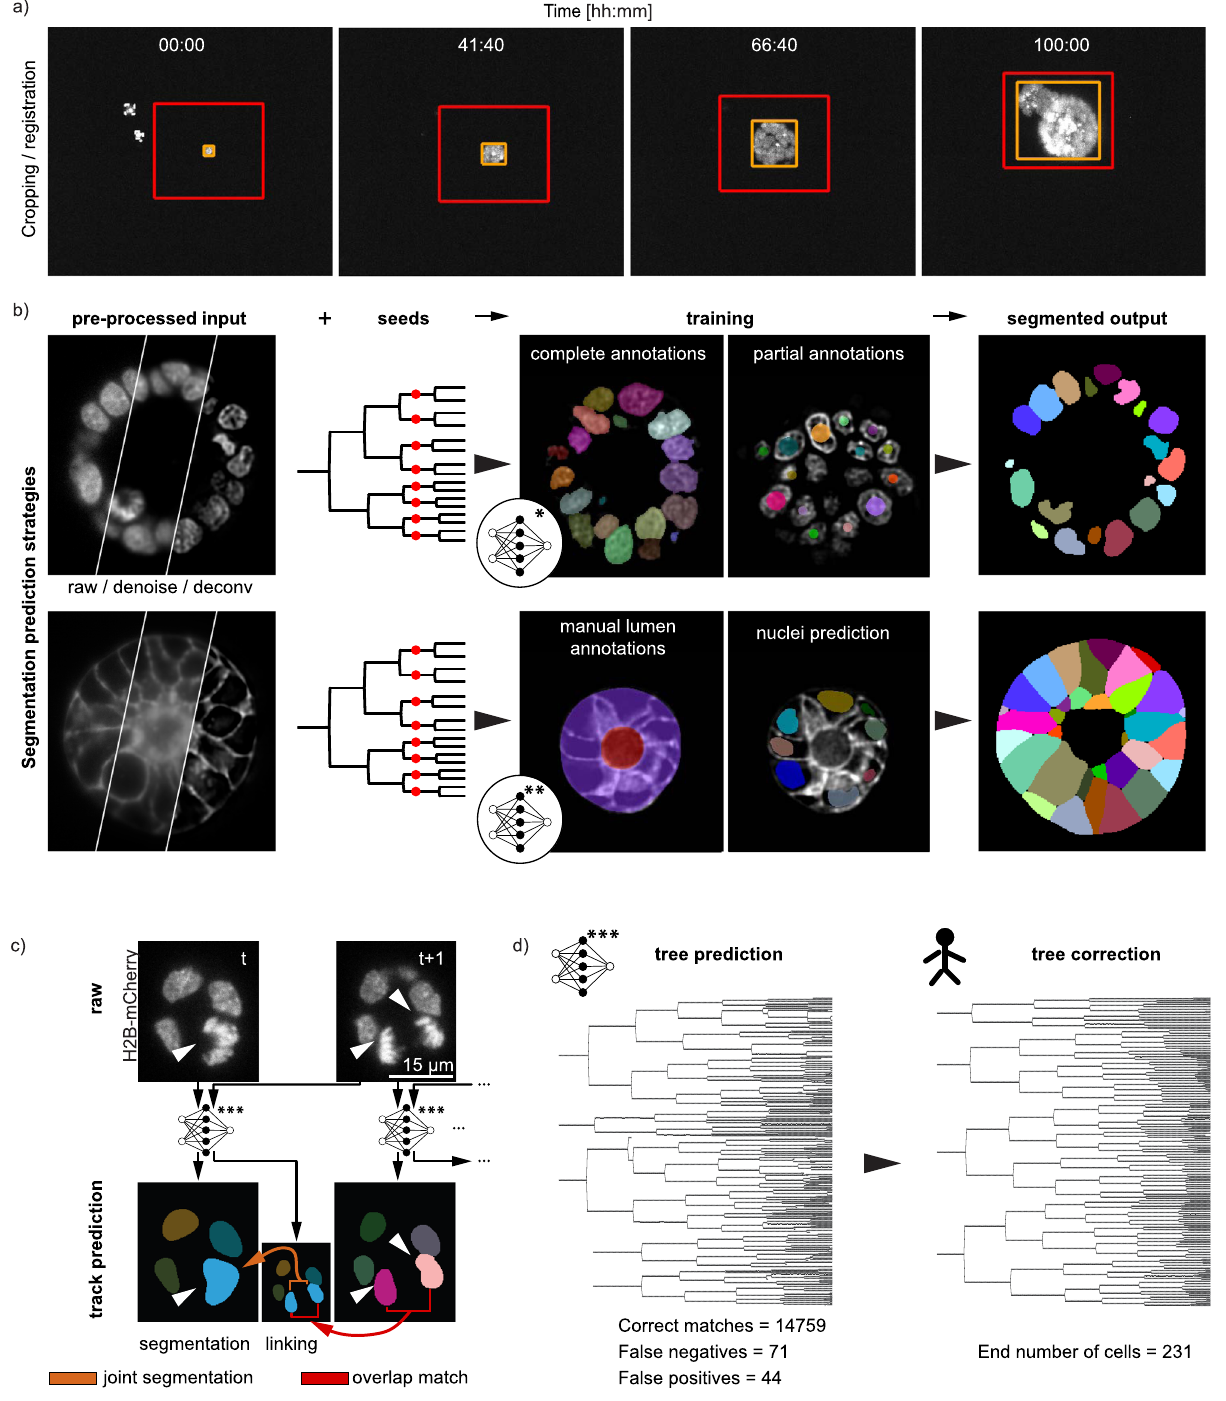
Fig. 2 | Cropping, segmentation and tree-prediction strategies underlying LSTree.a Croppingof datasets is done in a semi-automatic way: selected objectof interest is fi ttedwith anorange(best fi t for each particular timepoint) and a global red bounding boxes, whichcan be correctedin3D. b Nuclei and cell segmentation strategies. Upper row: denoised and deconvolved input data together with seeds from respective tracking are used as input into the network to predict nuclei volume.The networkistrainedwith both complete and partialannotations. Lower row: Cell volume prediction follows similar input as for nuclei. Main difference is